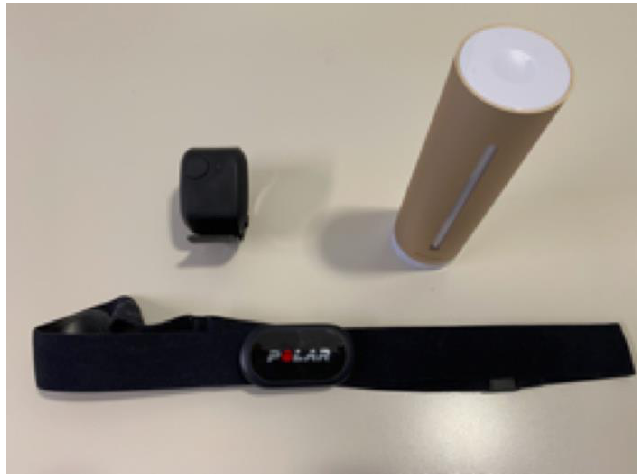
Figure 1. Sensors used in the experiment.